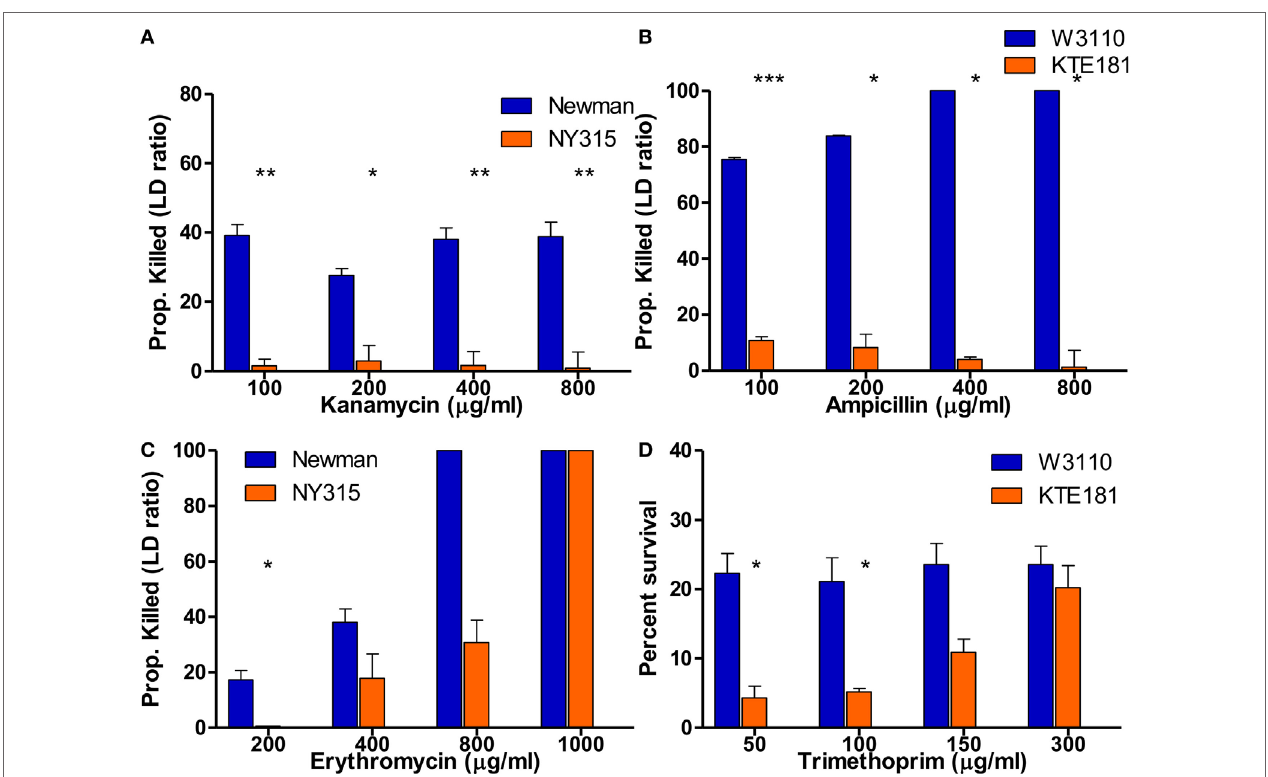
FigUre 5 | SYBR Green I/propidium iodide (PI) assay reveals killing of bactericidal and bacteriostatic antibiotics in 30 min. SYBR Green I/PI assay reveals killing between sensitive and resistant strains after treatment with increasing concentrations of bactericidal drugs (a) kanamycin for Staphylococcus aureus and (B) ampicillin for Escherichia coli . Upon treatment with increasing concentrations of bacteriostatic drugs (c) erythromycin for S. aureus and (D) trimethoprim for E. coli , SYBR Green I/PI assay was consistently able to distinguish sensitive and resistant strains when administered at different concentrations for both sensitive and resistant strains (Student’s t -test, * p < 0.05, ** p < 0.005, *** p < 0.0005). Data represent the means +